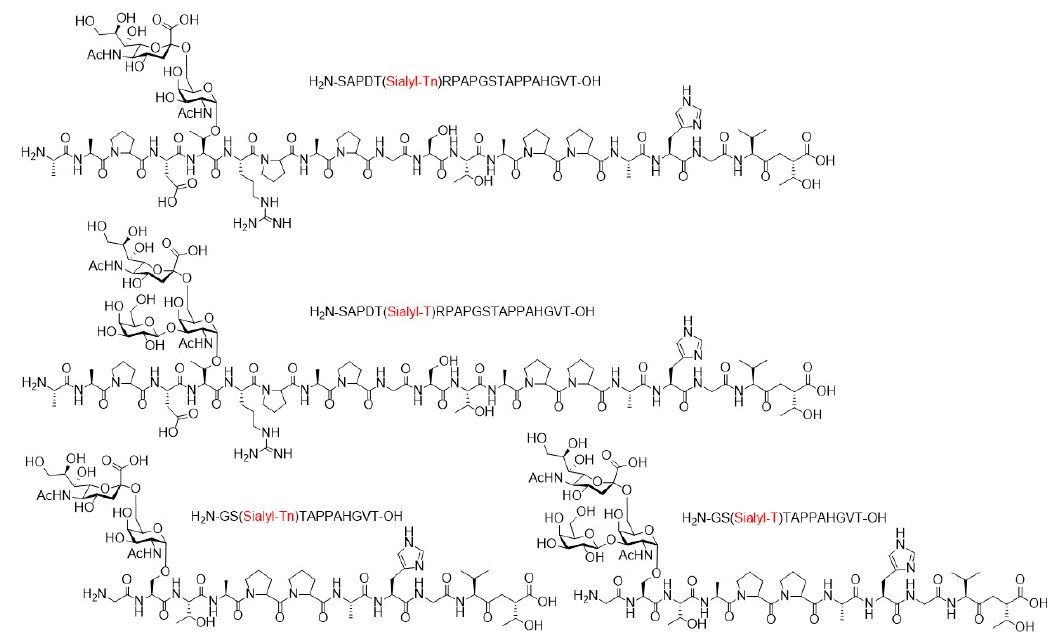
Figure 16. Structures of MUC1 2,6-sialyl-Tn- and 2,6-sialyl-T-antigen peptides. The 20mer MUC1 glycopeptides consisting of the tandem